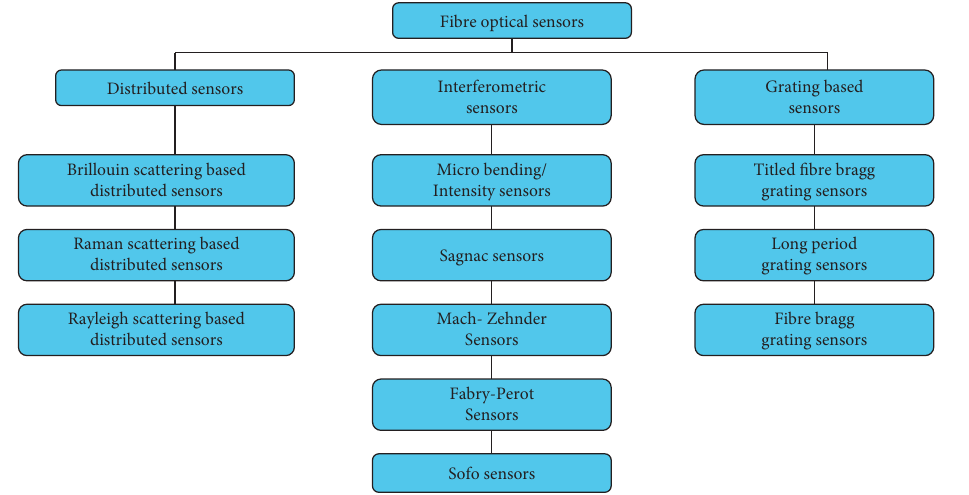
Figure 6: Fiber optic sensors in